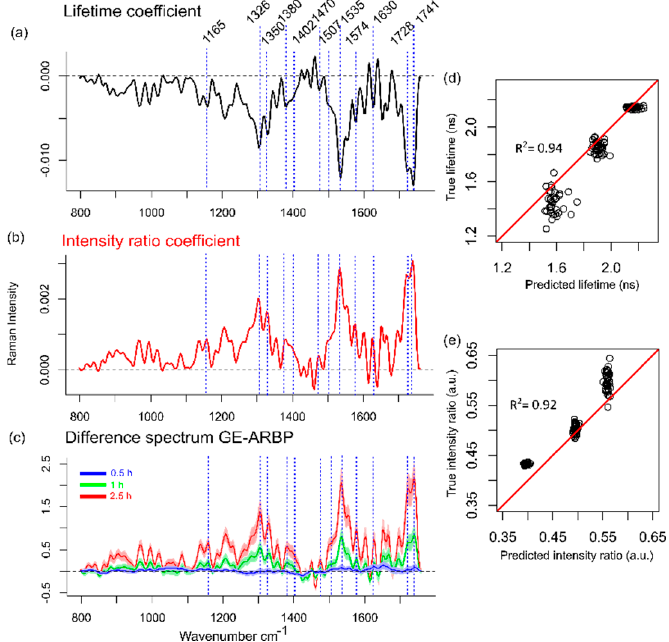
Figure 5. Multivariate multiple regression results show the correlation coefficients of fluorescence parameters lifetime ( a ) and intensity ratio ( b ) in SB3. ( c ) Mean (solid line) and standard deviation (shaded area) of the difference spectra between GE-ARBP and untreated ARBP at 0.5, 1, and 2.5 h. Experimental (or true) lifetime ( d ) and intensity ratio ( e ) values versus their predictions (red: corresponds to the ideal regression line with R 2 = 1).